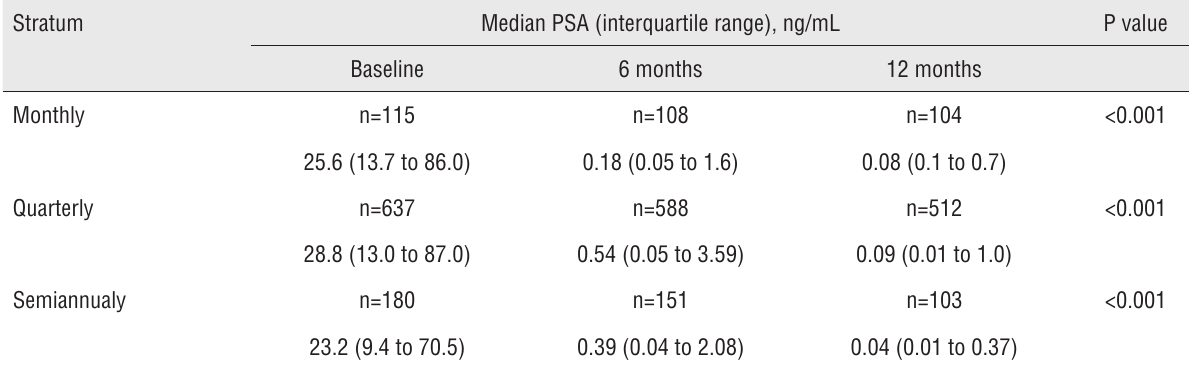
Table 2 - Serum prostate specifi c antigen (PSA) levels versus leuprolide schedule. Stratum Median PSA (interquartile range), ng/mL